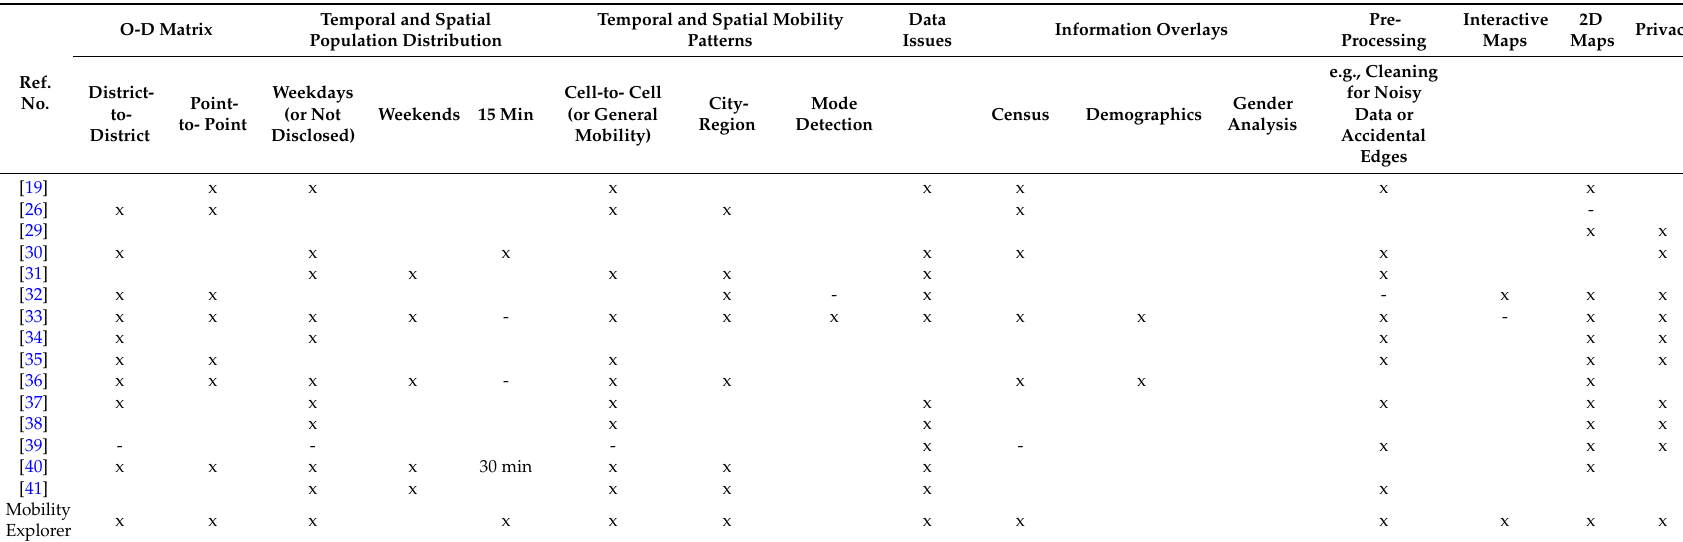
Table A1. Matrix of references dealing with the topic CDR data analysis and